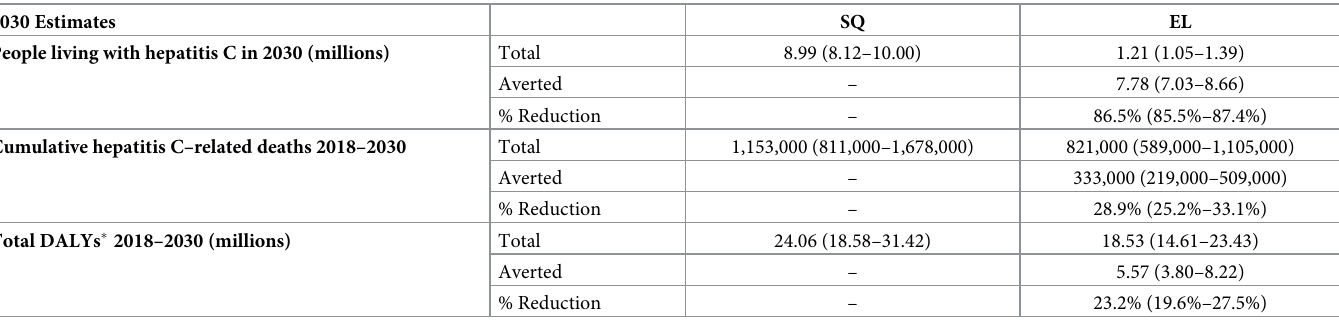
Table 3. Model projections of the HCV-related morbidity and mortality due to the SQ and EL scenarios over 2018 to 2030. DALYs are discounted at a rate of 3.5% per annum. The values represent the median and 95% UIs across 1,151 model fits. 2030 Estimates SQ People living with hepatitis C in 2030